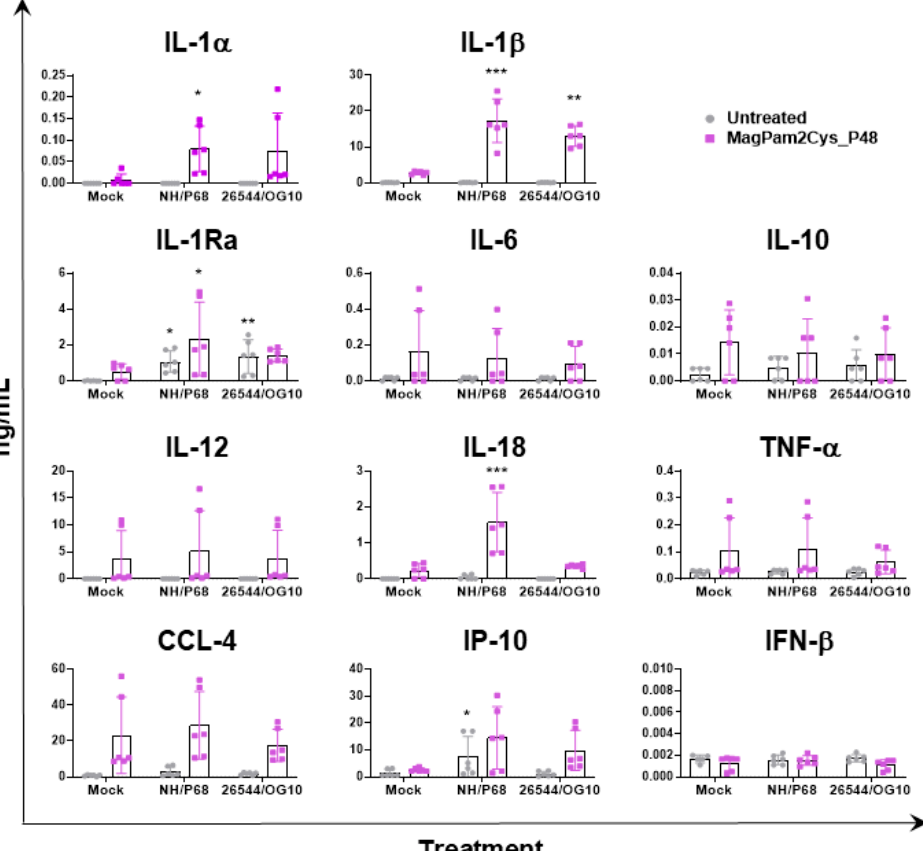
Figure 4. Impact of MagPam2Cys_P48 on cytokine release by moM Φ in response to ASFV infection. Porcine moM Φ were left untreated or stimulated with MagPam2Cys_P48 (100 ng/mL). Twenty-four hours later, cells were infected with either attenuated NH/P68 or virulent 26544/OG10, using a MOI of 1. Mock-infected samples were used as controls. At 21 hpi, culture supernatants were collected, and levels of IL-1 α , IL-1 β , IL-1Ra, IL-6, IL-10, IL-12, IL-18, TNF- α , IP-10, CCL-4, and IFN- β were determined using a multiplex or singleplex ELISA. The mean data ± SD from three independent experiments using different animals are presented. For each macrophage subset, values of ASFV-infected macrophages were compared to the corresponding mock-infected control, using a one-way ANOVA followed by Dunnett’s multiple comparison test or a Kruskal–Wallis test followed by Dunn’s multiple comparison test; *** p < 0.001, ** p < 0.01, * p < 0.05.